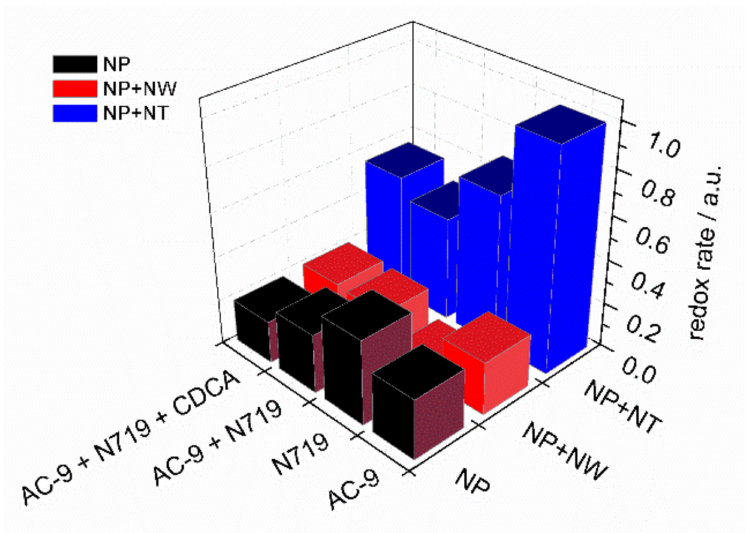
Figure 7. Comparison of the charge transfer rates for 12 types of studied cells. The data is based on inverse charge transfer resistance values measured at 0.6